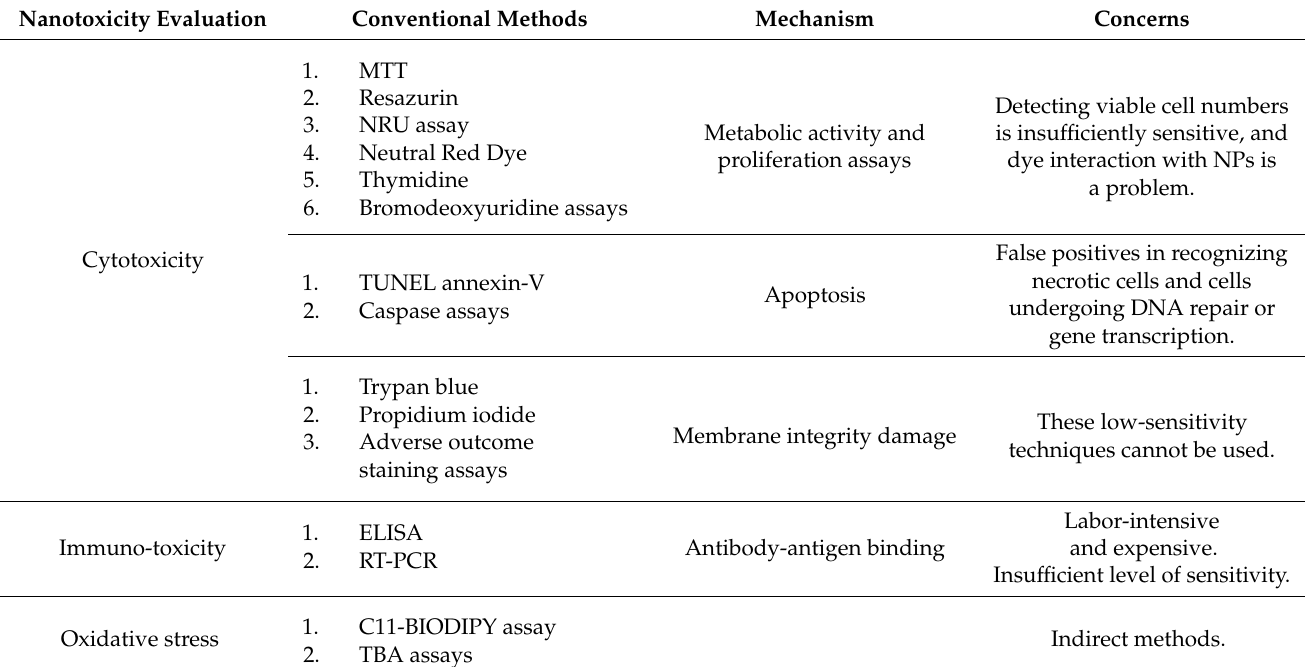
Table 1. Conventional methods to demonstrate concerns for the bio-evaluation of nano-based